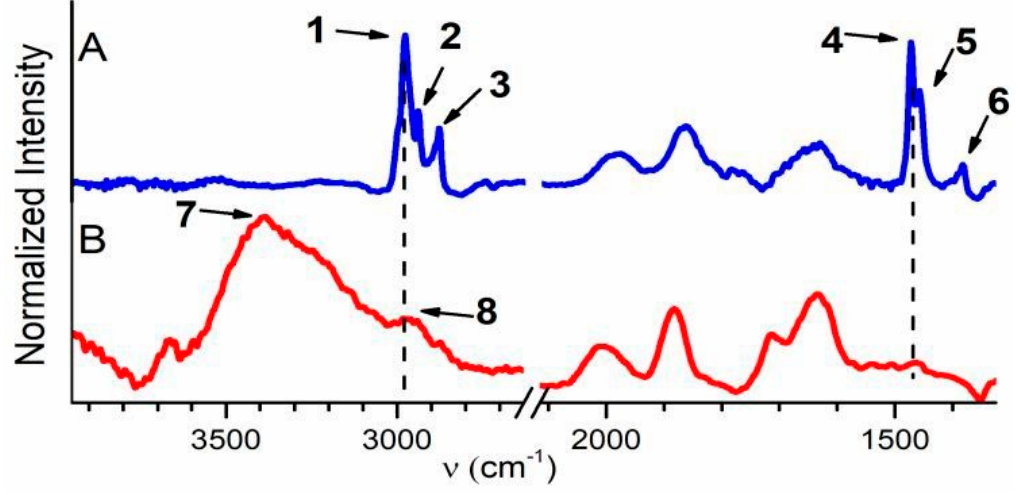
Figure 2. FTIR spectra of sample SF-AS ( A ) and SF-500 ( B ).